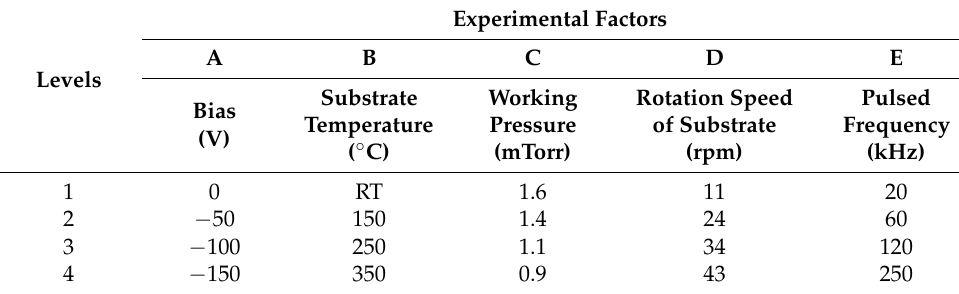
Table 1. Experimental factors and